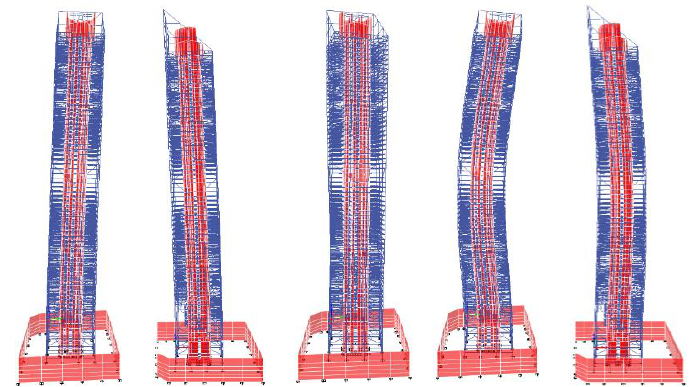
16 of 20 Figure 15. Mode shapes identified via SSI and root-mean-square (RMS) methods against code predictions for the first two swaying modes (i.e., Mode 1 and Mode 3) and the first torsional mode (Mode 2). ( a ) Dir-X; ( b ) Dir-Y. 4.4. Comparison with Finite Element Results A finite element model is established via a beam-slab modeling method in accordance with the structural information of the studied building at its design stage. Twelve-node beam elements and four-node elastic plate elements are employed to model the main body of the structure, three- dimensional link elements are adopted to model the supporting components, and mass elements are used to model the live loads and the nonstructural components. Modal analysis is performed based on the established model via the ETABS software. Relevant results are shown in Figure 16 and Table 6.